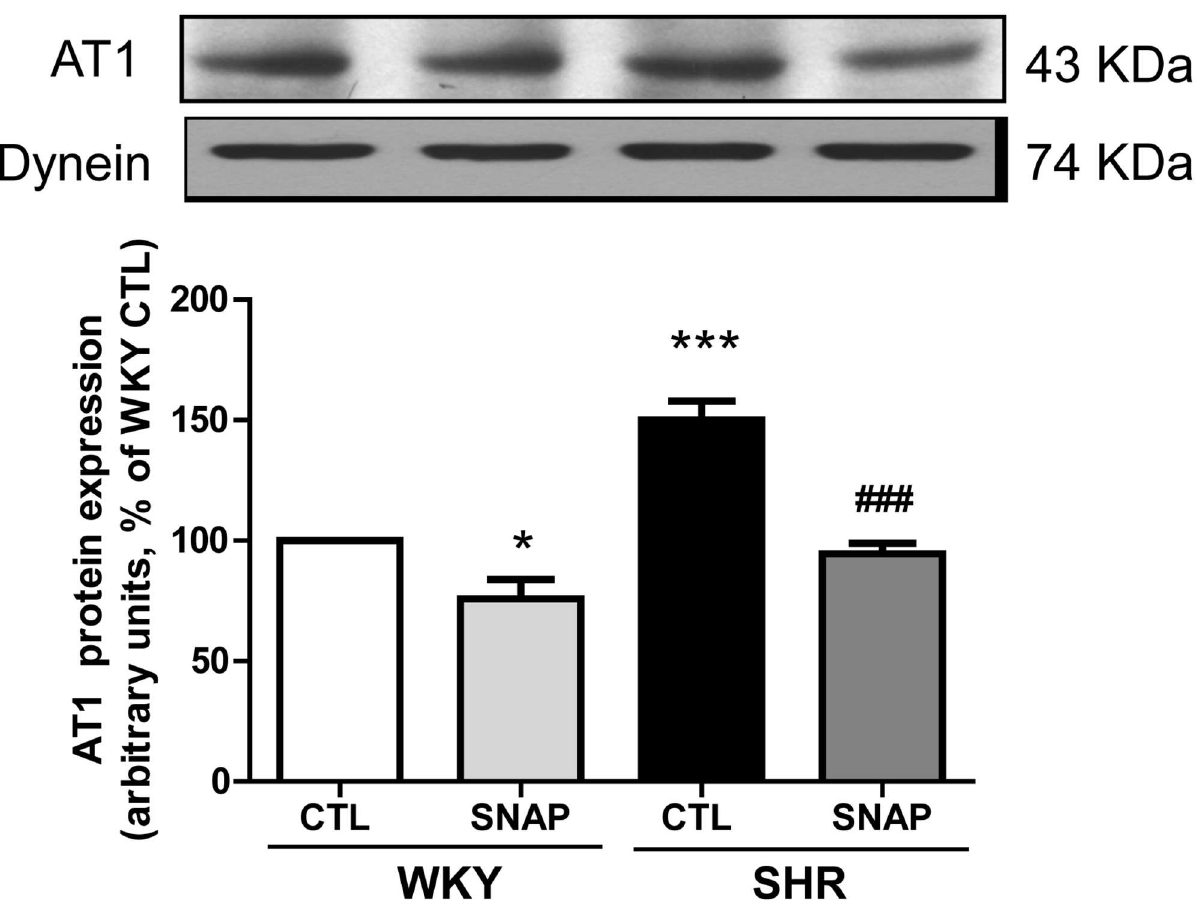
Fig 4. Effect of SNAP on the AT1 receptorexpression in the aortic vascularsmooth muscle cells (VSMC) from 12-weekold spontaneously hypertensive rats (SHRs) and age-matched Wistar-Kyoto (WKY) rats. ConfluentVSMCs were starved 24 h and incubatedin the absence(control) or presenceof SNAP (100 μ M) for 24 h. The cell lysates were preparedand subjectedto Western blot analysisusing specific antibodies againstAT1 (N-10) or dynein as loadingcontrol, (upper panel)as describedin the Materialsand methods. Quantificationof protein bandswas done by densitometric scanning(lower panel). The results are expressedas a percentage of the WKY control (CTL), taken as 100%. Values are the mean ± SD of 4 separateexperiments using different cell populationsfrom different animals. * P < 0.05, *** P < 0.001vs WKY CTL group, ### P < 0.001vs SHR CTL